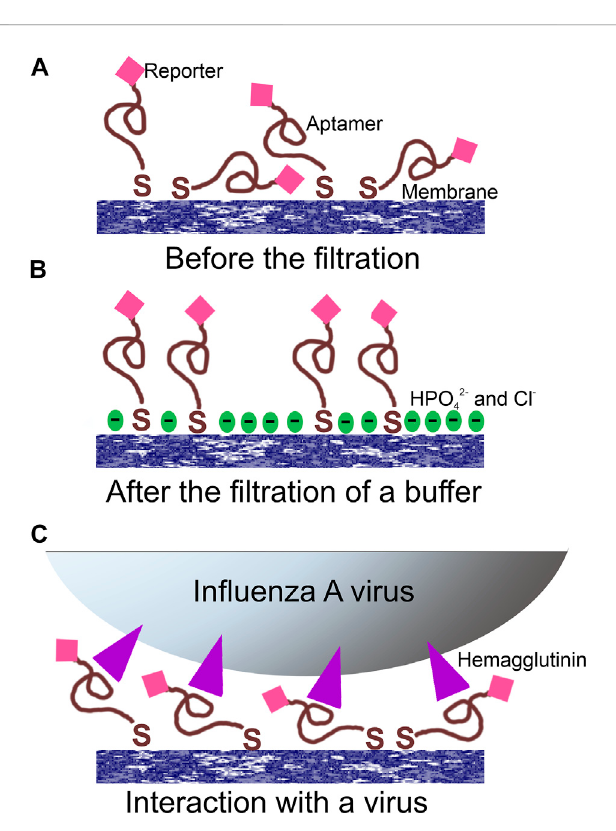
FIGURE 3 Proposed operating principle of the aptasensor. (A) Random orientation of the aptamer with the reporter toward the surface; (B) PBS fi ltration modi fi ed the surface providing a negatively charged surface with increased distance between the reporter and the surface; (C) the fi ltration of the virus provided speci fi c interactions between aptamers and viral particles orienting the reporter in the common manner near the Filtration through the membrane also affects intensities of SEF and SERS spectra of the reporter. The intensities of both SEF and SERS spectra were decreased substantially after the fi ltering of 200 µl of PBS (Figure 2). The decrease in the intensities of the spectra was not associated with the destruction of nanostructured